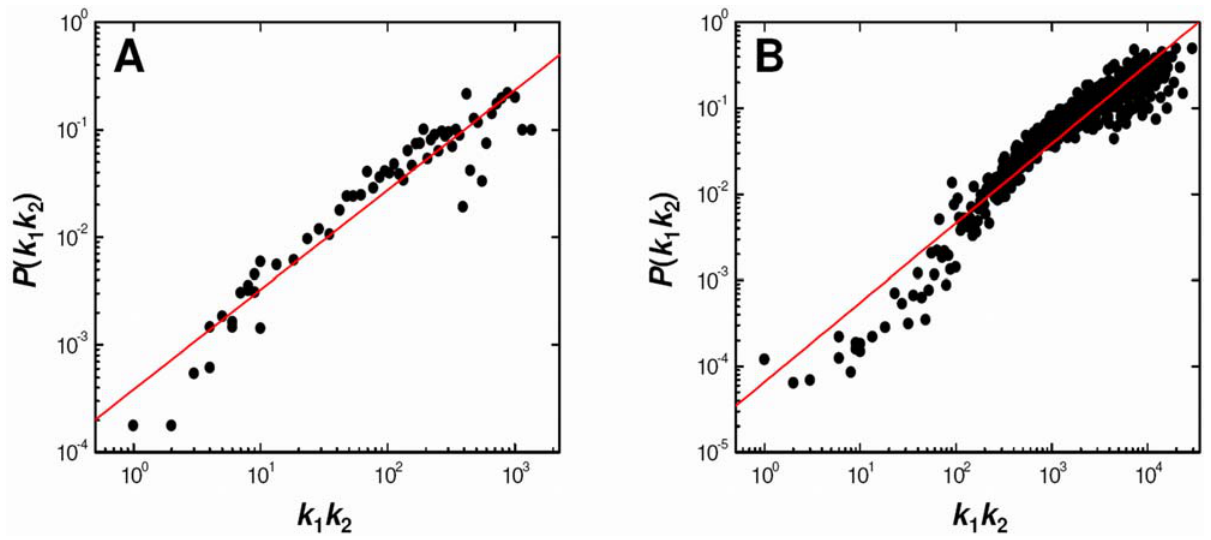
Figure 1. Evidence of Degree-Weighted Connectivity in Two PPI Networks. (A) Helicobacter pylori and (B) Campylobacter jejuni . For k 1 k 2 . 10, probabilities of interaction P ( k 1 , k 2 ) were ordered by k 1 k 2 and averaged in groups of 10.